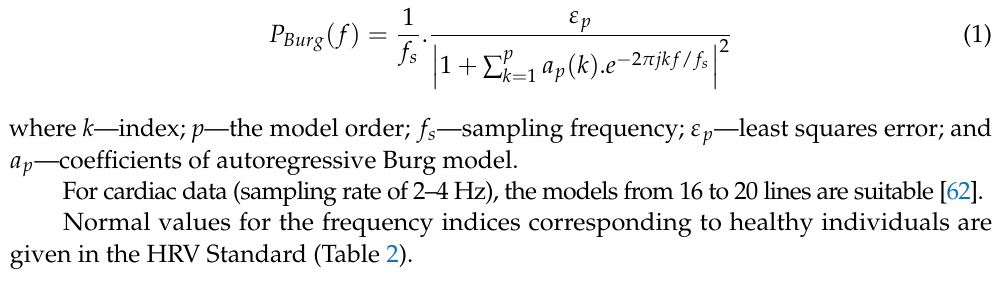
Table 2. Reference values for healthy individuals in the frequency domain